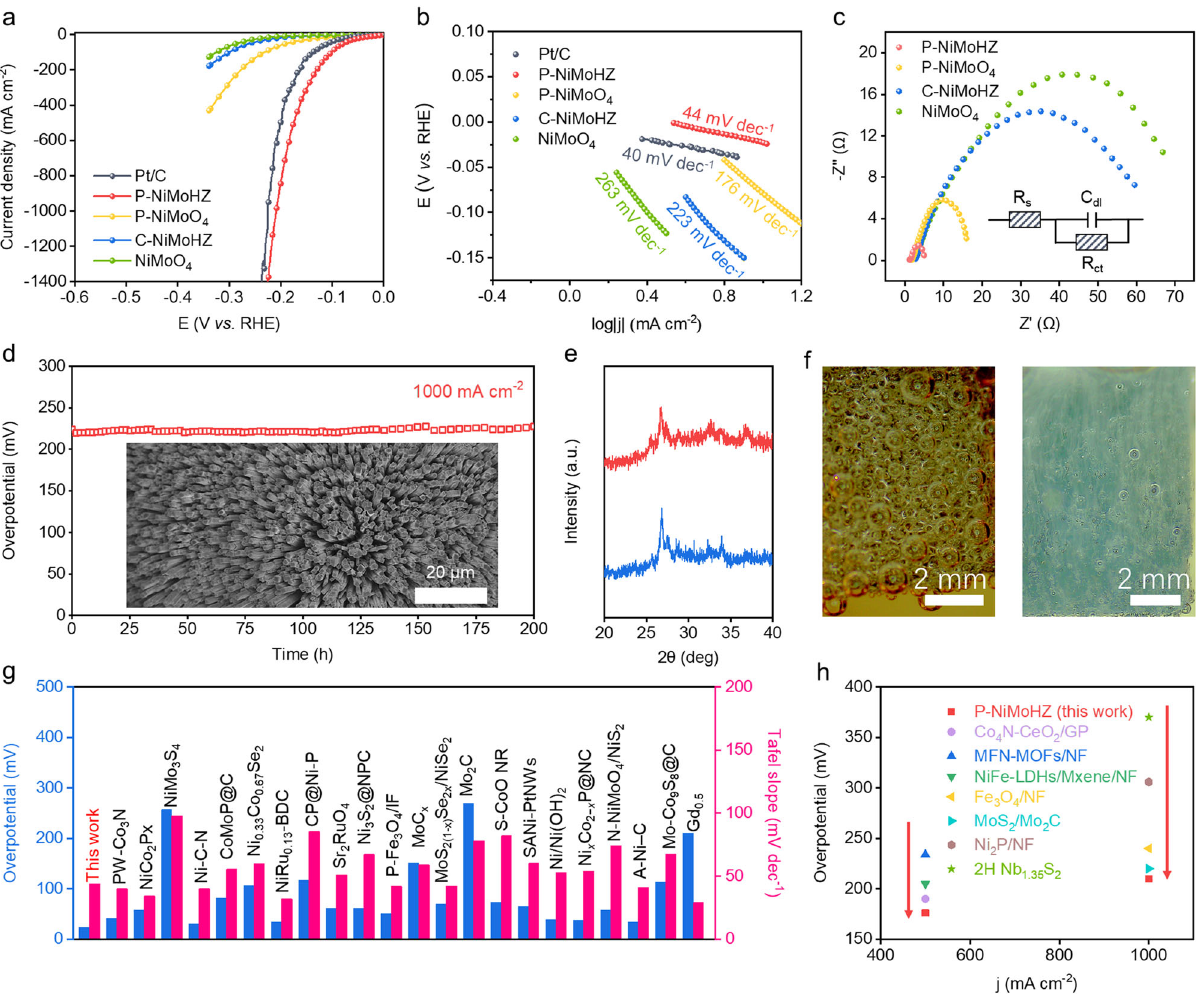
Fig. 3 Electrocatalytic properties for HER. a Polarization curves of NiMoO 4 , C-NiMoHZ, P-NiMoO 4 , P-NiMoHZ, and Pt/C in 1.0 M KOH saturated with N 2 gas at a scan rate of 5 mV s − 1 . b The corresponding Tafel plots. c Nyquist plots. The inset is the equivalent circuit schematic. d Long-term stability tests of P-NiMoHZ at large current density (1000 mA cm − 2 ). Inset: the SEM image of P-NiMoHZ after the stability test. e XRD patterns of the P-NiMoHZ before and after the stability test. f Photographs of the electrode during HER electrocatalysis (left: NiMoO 4 ; right: P-NiMoHZ). g , h The comparison of overpotentials and Tafel slopes of P-NiMoHZ and other reported catalysts at small ( g ) or large current density ( h